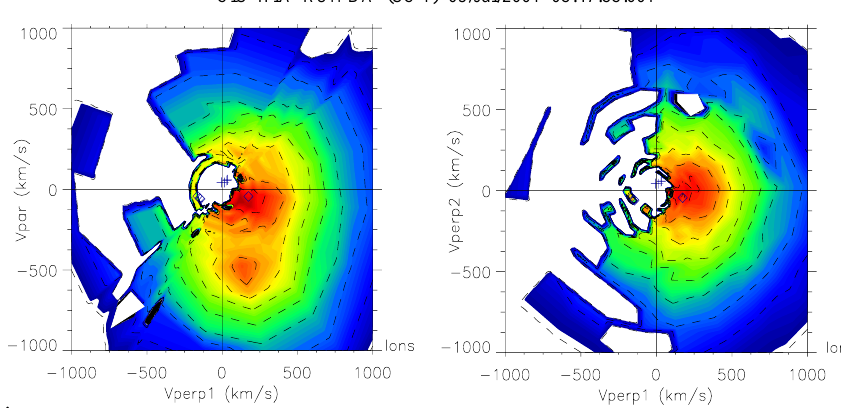
Fig. 13. The left panel shows ion distribution function at parallel/perpendicular-plane (right panel has perpendicular cut) from HIA instrument onboard sc1 at 05:47:55